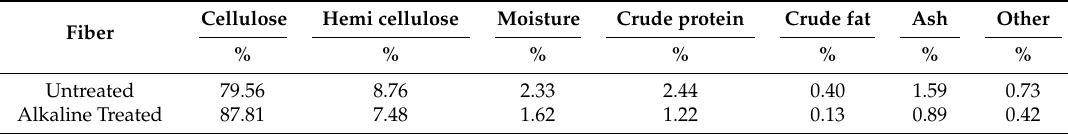
Figure 2. SEM images of flax fiber; ( a ) untreated; ( b ) alkaline treated. Table 1. Constituent analysis of untreated and alkaline treated flax fibers.